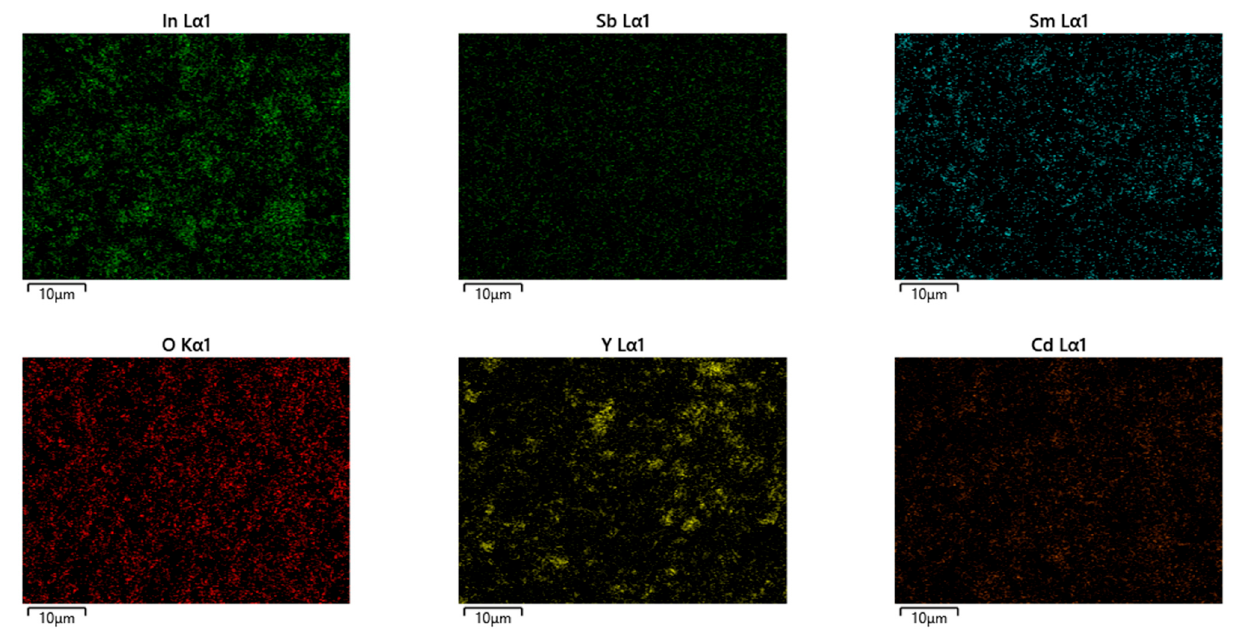
Figure 11. EDS elemental mapping of In 2 CdO 4 /Y 2 SmSbO 7 heterojunction (In, Cd, O from In 2 CdO 4 and Y, Sm, Sb, O from Y 2 SmSbO 7 ).